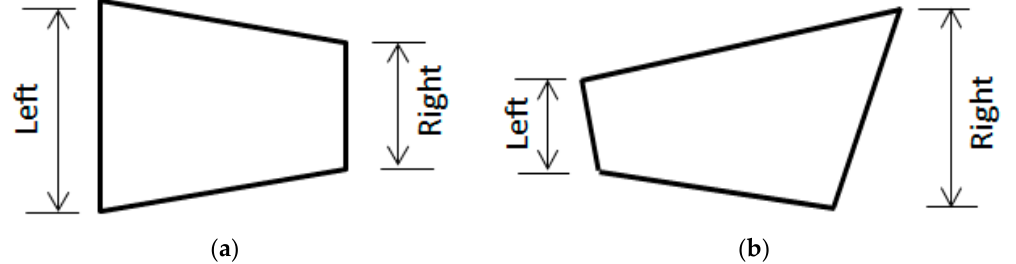
Figure 16. How to measure the length of vertical sides. ( a ) If the vertical sides are parallel; ( b ) If the vertical sides are not parallel.